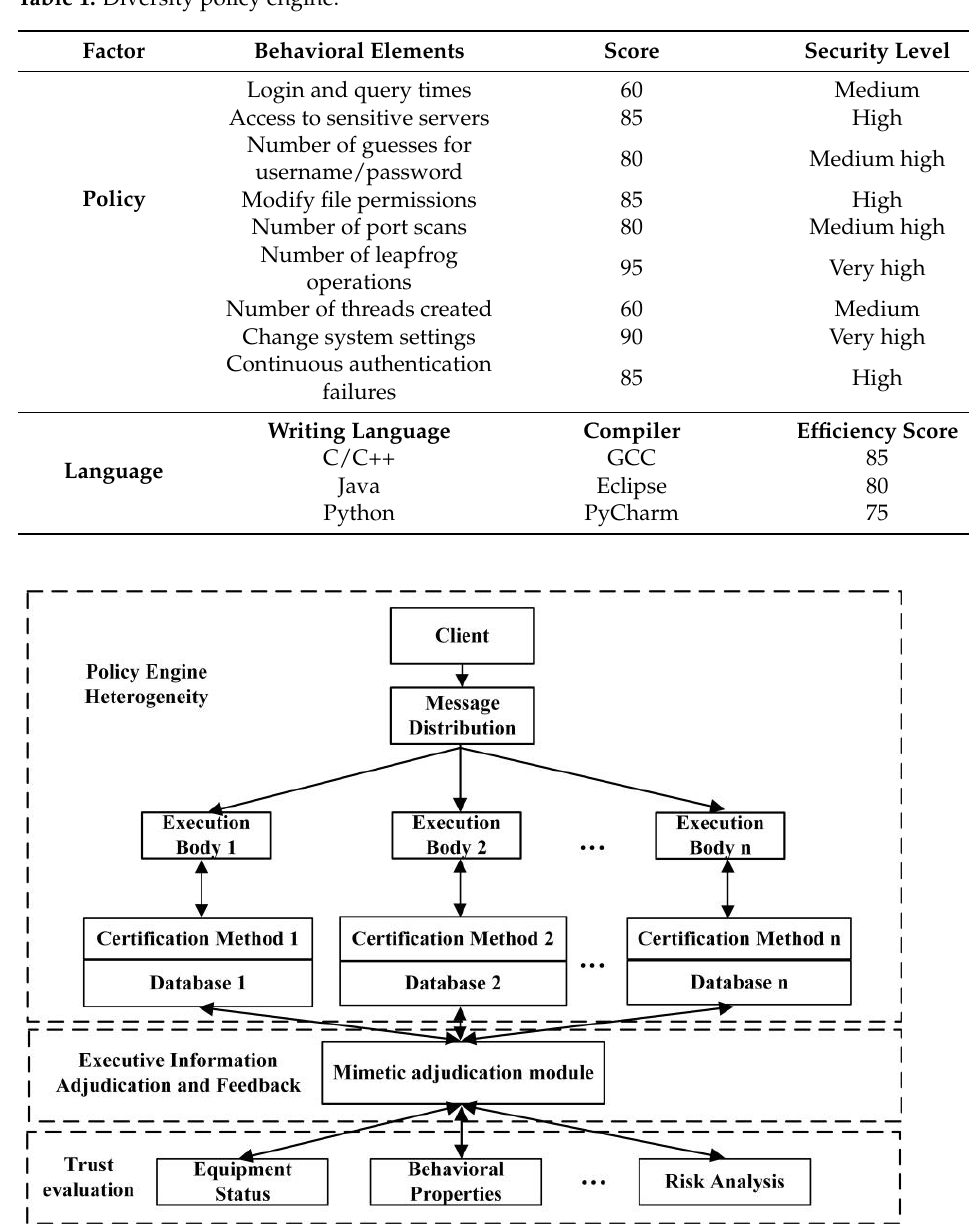
Figure 4. Mimic authentication.